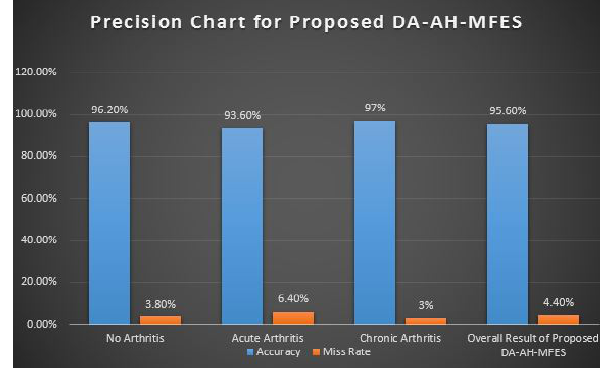
Figure 10. Precision Chart of Proposed DA-AH-MFES Expert